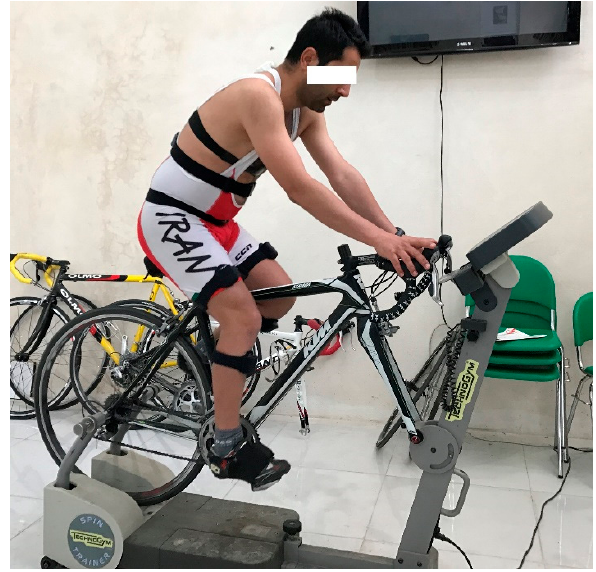
Figure 1. MyoMotion sensors placements on segments.